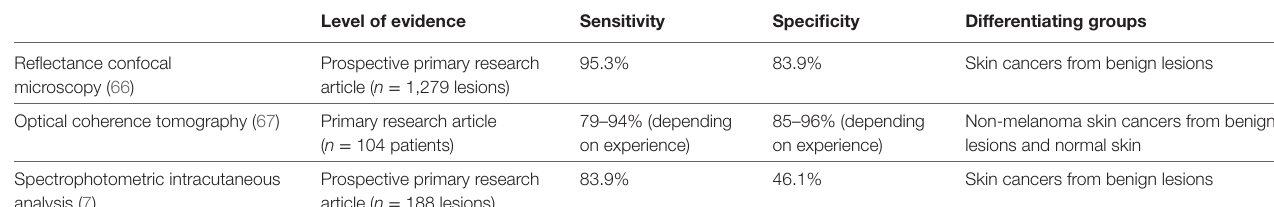
TaBle 3 | Receiver operating characteristics for infrared-based imaging modalities in identifying malignant lesions compared with